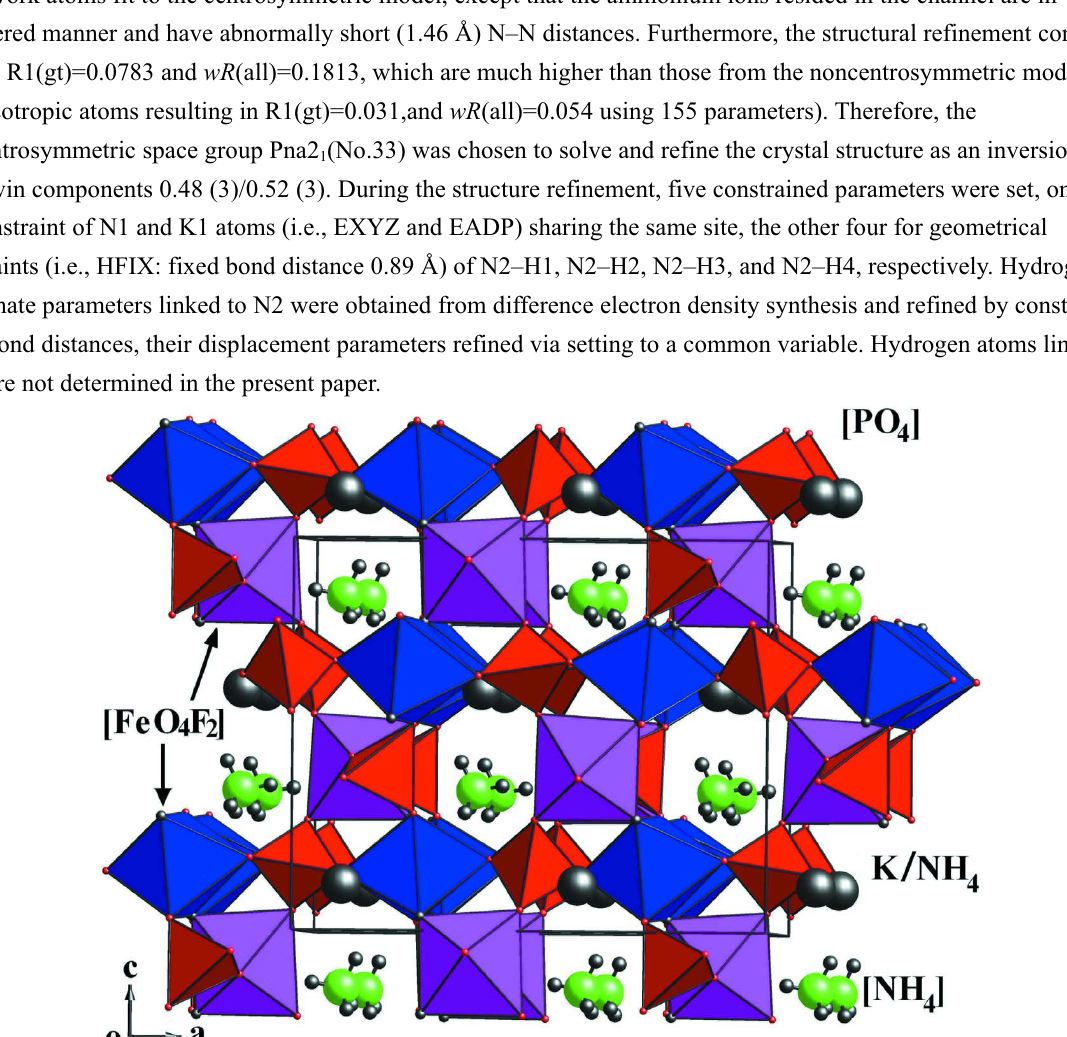
)((NH ) K ) [Fe (PO ) F ] in a view along b. Trans -[FeO 4 4 0.75 0.25 2 4 2 2 , in red tetrahedra; black spheres: disordered K/NH 4